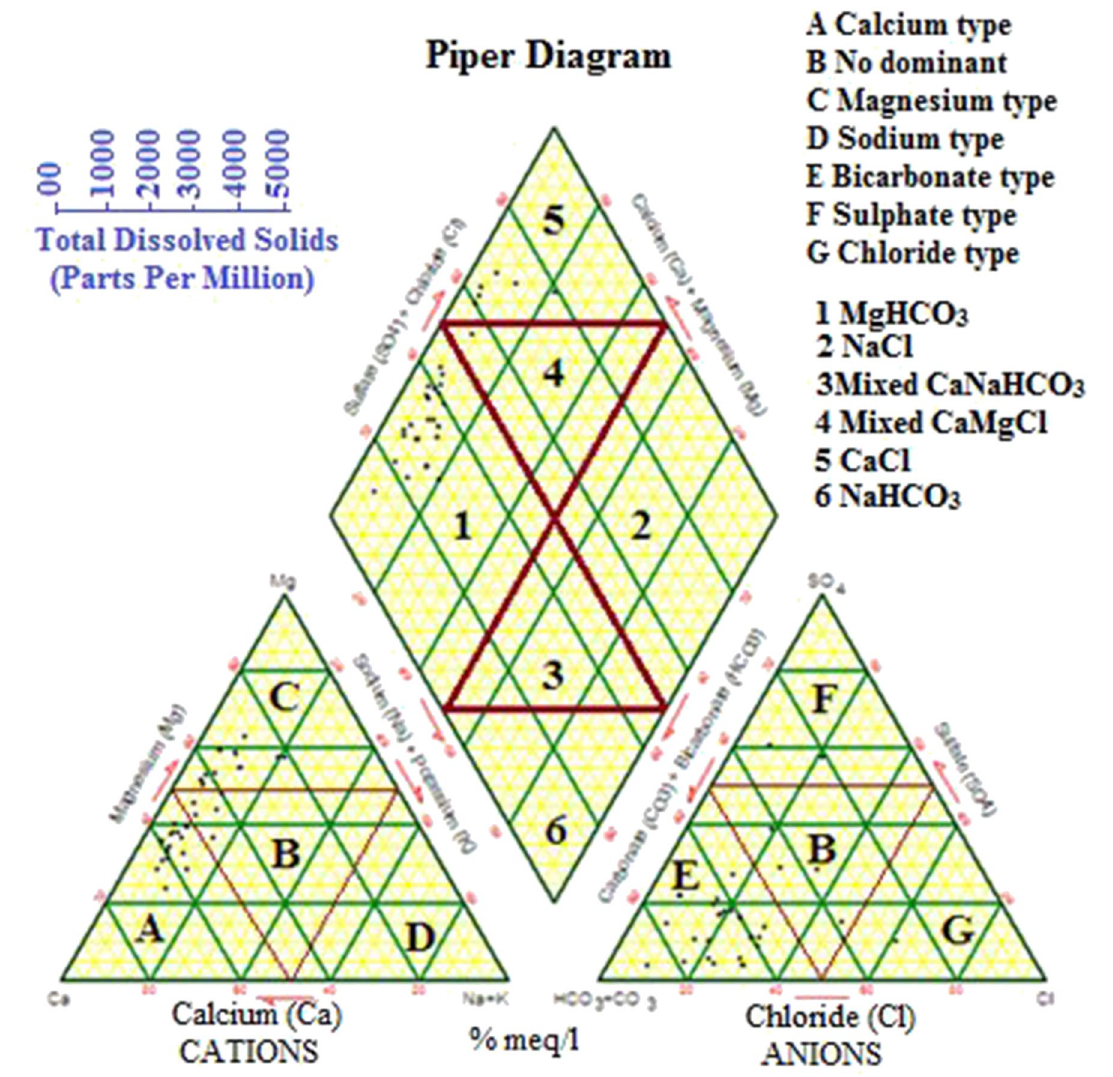
Fig. 6 Piper classification diagram illustrating the chemical composition of groundwater in